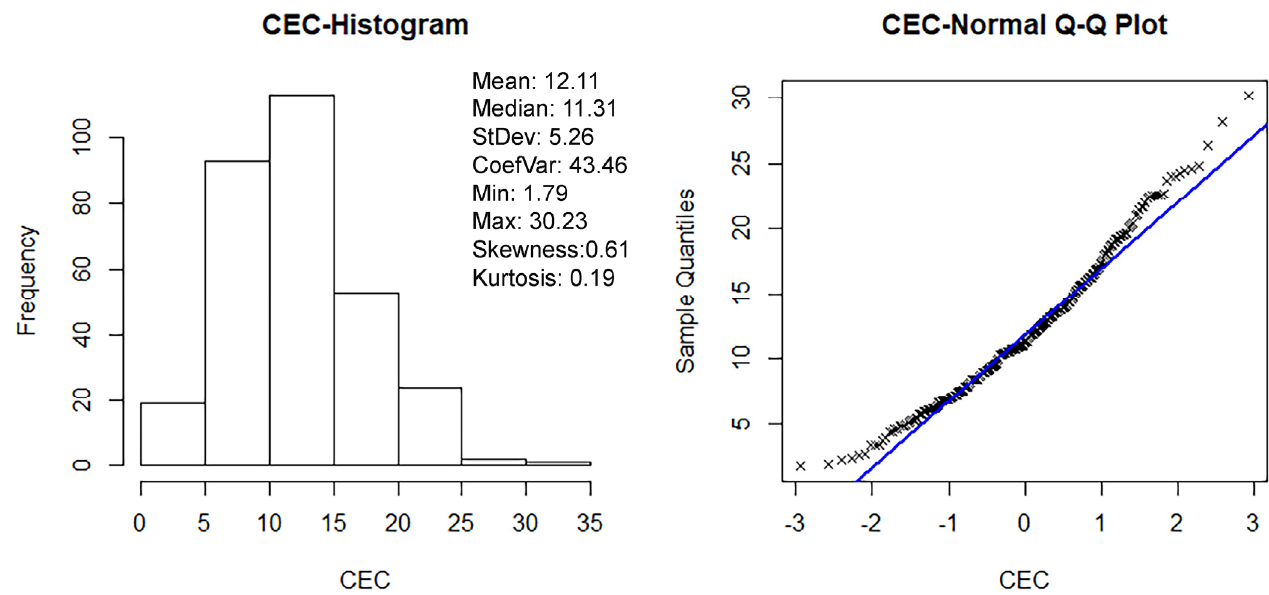
Figure 3. Histogram and Q-Q plot of measured CEC in the dataset.